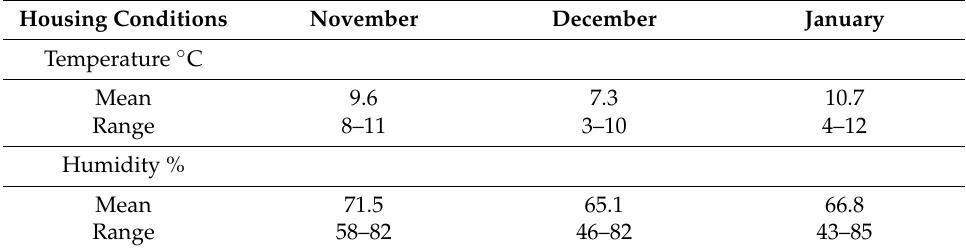
Table 1. Monthly averages of the stable air temperature and